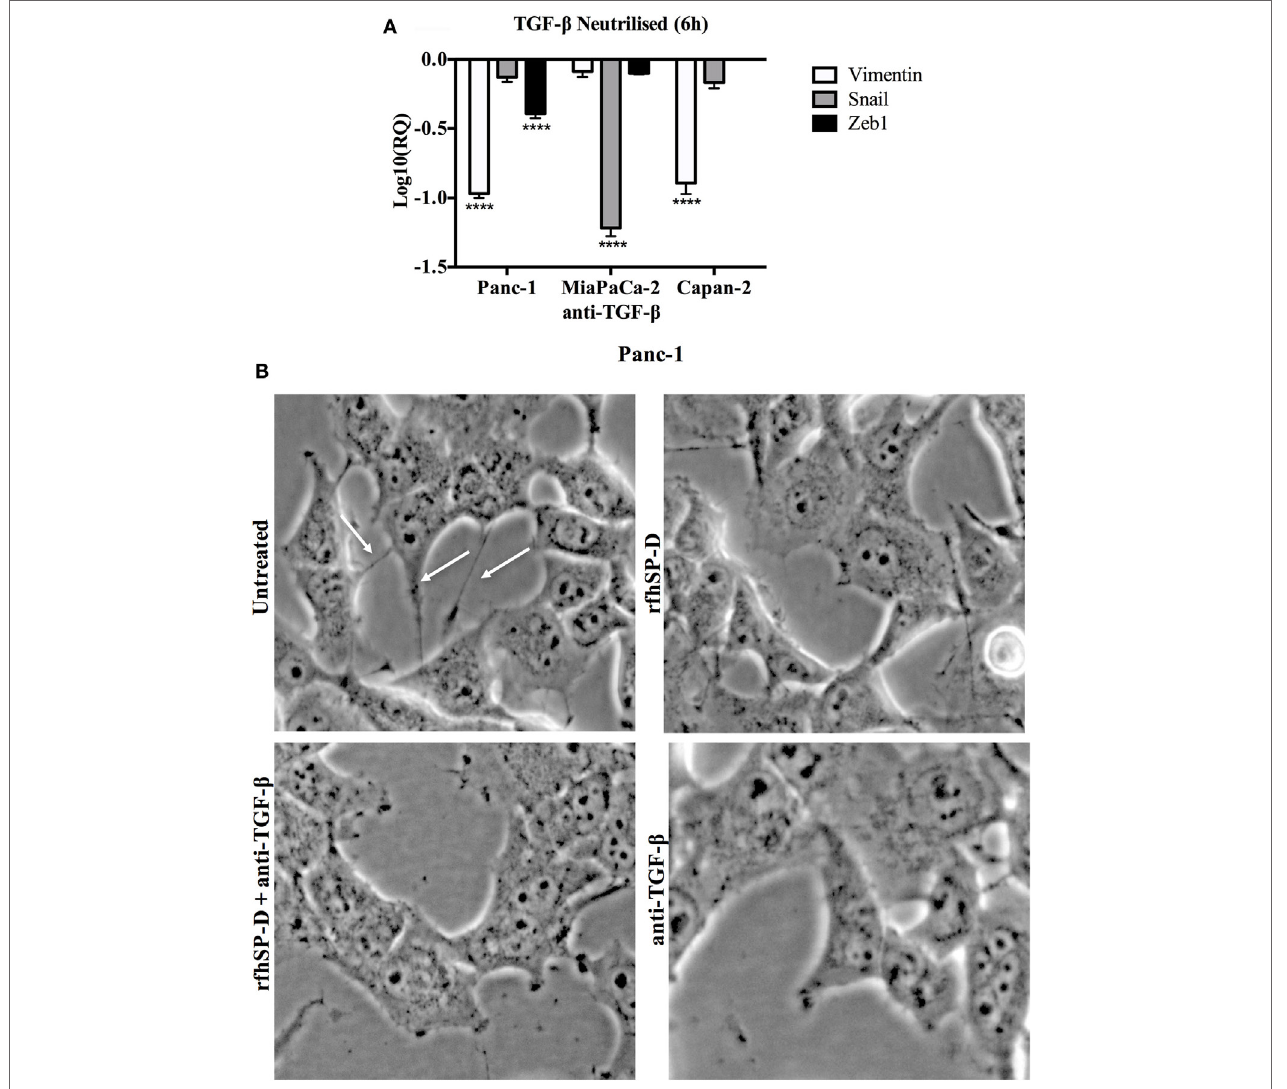
FigUre 7 | (a) TGF- β caused downregulation of epithelial-to-mesenchymal transition (EMT) markers. All cell lines were incubated with TGF- β neutralizing antibody for 6 h to analyze the gene expression of Vimentin, Snail, and Zeb1, which showed that all EMT markers were downregulated in a manner similar to recombinant fragment of human SP-D (rfhSP-D) treatment. Significant values were considered based on **** p < 0.0001 between treated and untreated samples. (b) Analysis of images taken at 6 h following the treatment with rfhSP-D, anti-TGF- β , both rfhSP-D and anti-TGF- β and untreated begins to show less branches (highlighted with white arrows in UT) and decreased cell movement in all the treated samples as compared to untreated control, which translates into significant difference by 24 h as shown in cell invasion